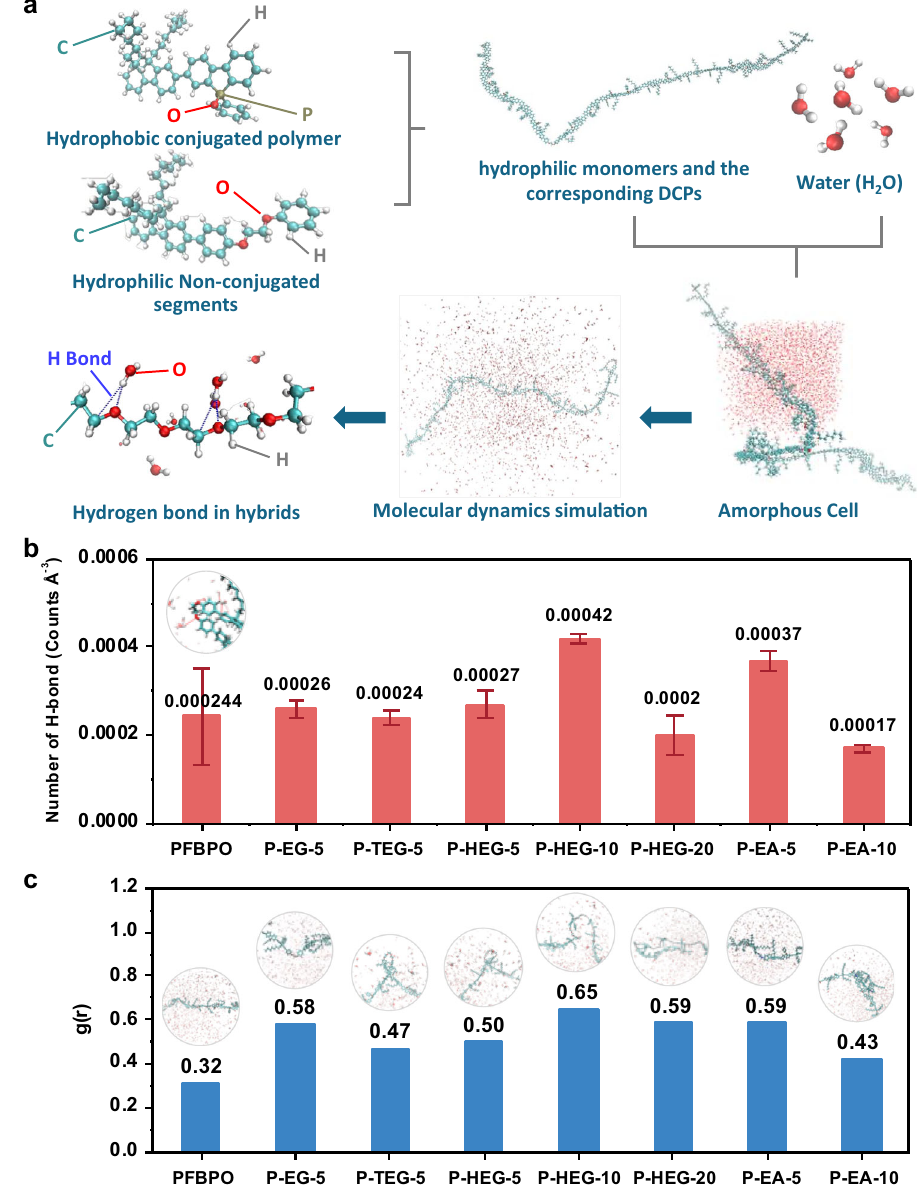
Fig. 6 | Molecular dynamics simulations. a The work fl ow of molecular dynamics study. The conjugate polymer models were built according to the overall mass and different repetition units. The system was fi lled with water